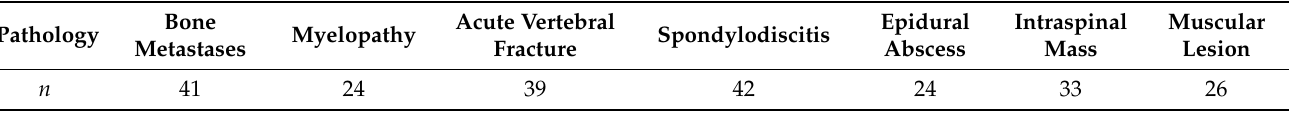
Table 3. Distribution of pathologies across the validation cohort. Each scan in which a pathology occurs once or several times was counted as